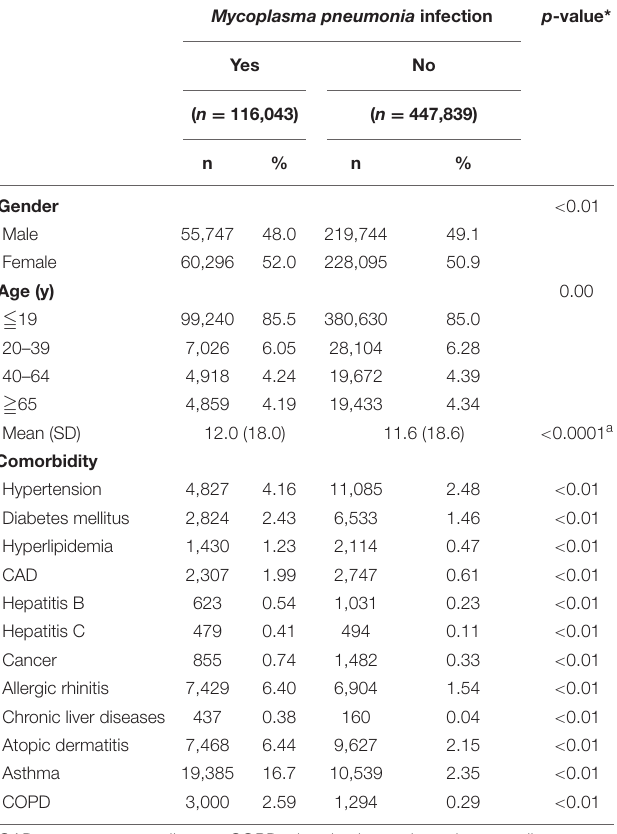
TABLE 1 | Baseline characteristics of the study population. Mycoplasma pneumonia